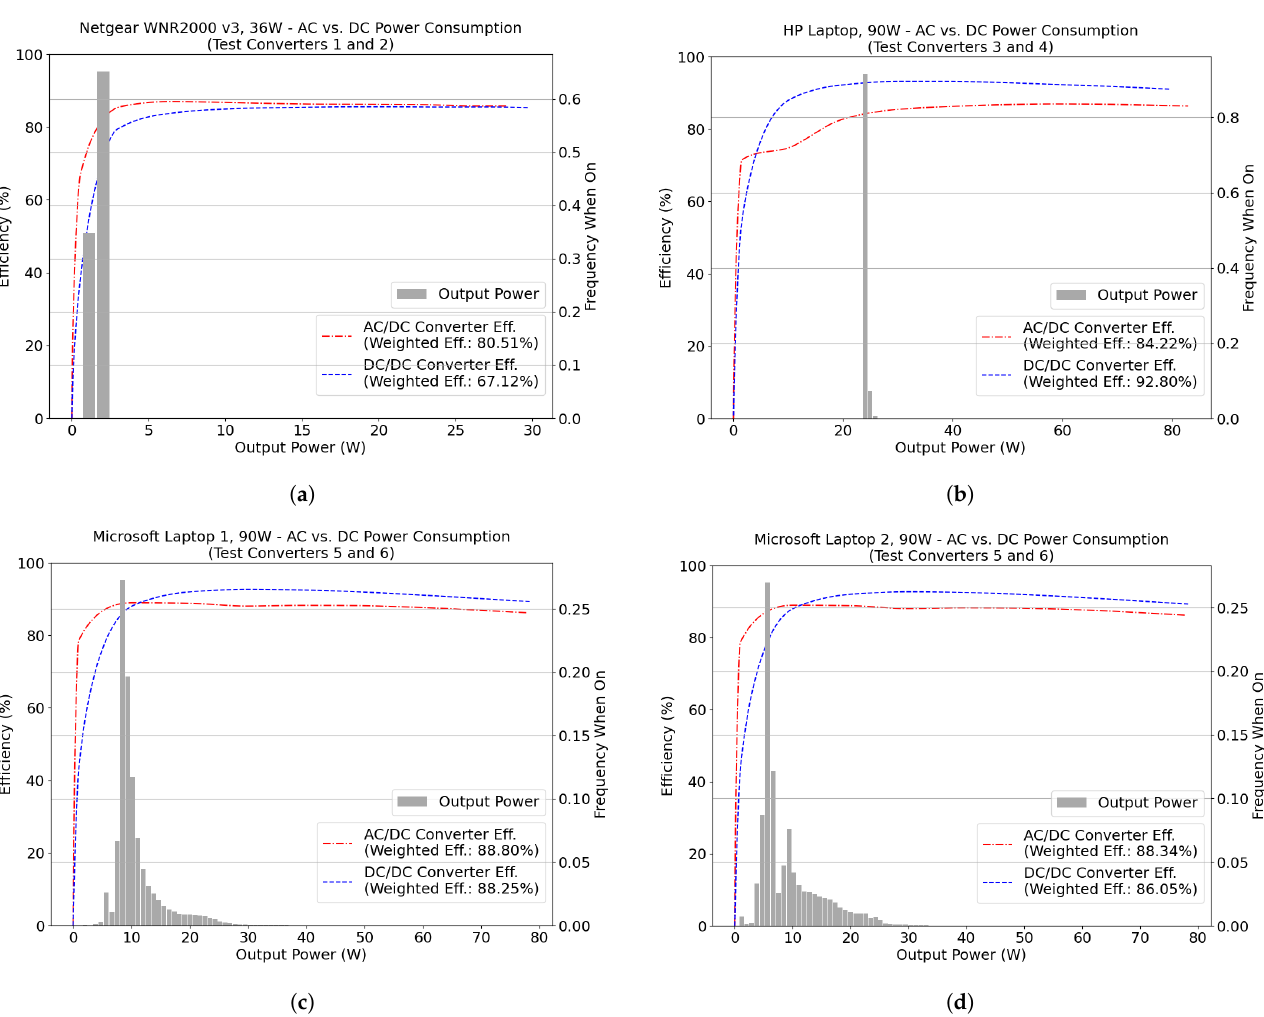
Figure 3. Weighted energy efficiency for SISO converters, assuming load profiles for: ( a ) HP Laptop, 90 W ( b ) Microsoft laptop 1, 90 W ( c ) Microsoft laptop 2, 90 W, and ( d ) Netgear WNR2000 v3. Efficiency curves for the test converters are represented by the dotted lines, and probability distribution of load for each MEL is represented by the histogram. Legend provide the weighted energy efficiency for each converter, over the period in which power was monitored ( ≈ 2 months). Table 4. Delta Efficiency (DC-AC) for pairs of test converters and AC and DC weighted energy efficiency for each appliance.